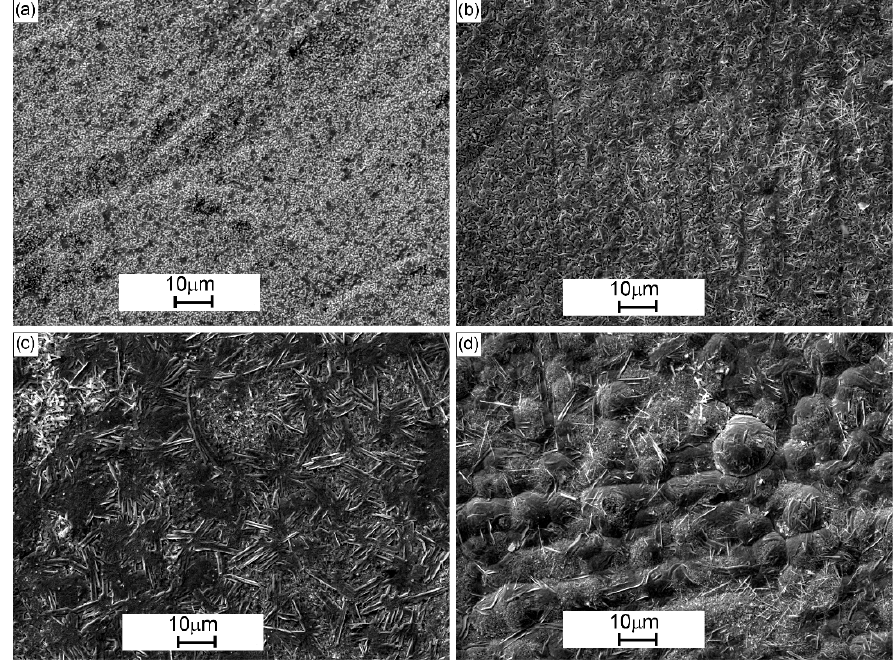
Figure 1. Surface morphology of Ni-W coatings after heat treatment in the air, in dependence on deposition current density: ( a ) C125/1173, ( b ) C150/1173, ( c ) C175/1173 and ( d ) C200/1173.